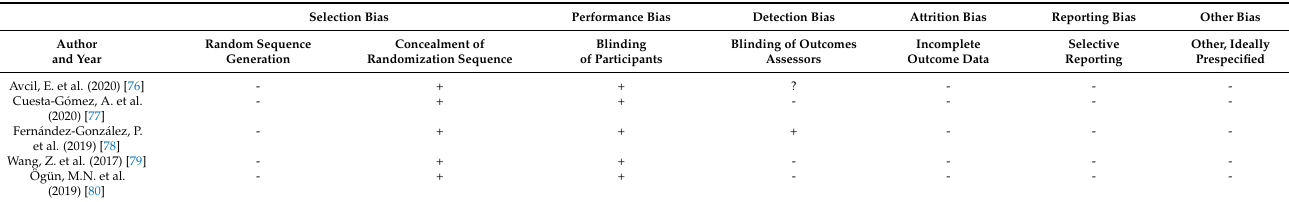
Table 3. Cochrane Risk of Bias assessment of the included studies.